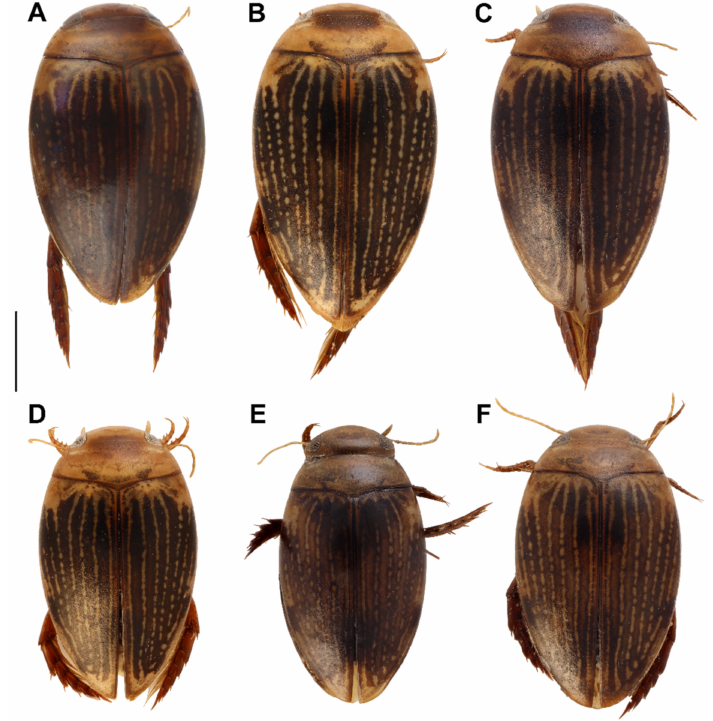
Figure 2. Habitus images of Laccophilus alluaudi species group members from Comoro Islands: ( A ) L. tigrinus (male, PT 13265); ( B ) L. tigrinus (female); ( C ) L. denticulatus (male); ( D ) L. mohe- licus (male); ( E ) L. mayottei (male); ( F ) L. michaelbalkei (male). Scale bar 1 mm. Note that ( A ) (Photo: MNHN/Christophe Rivier) is photographed under different circumstances (equipment, angle and resolution).